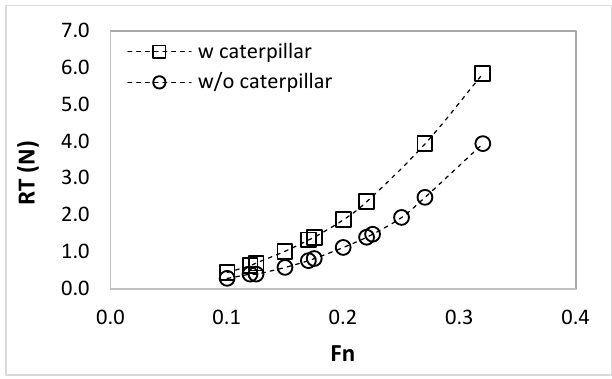
Figure 4. Numerical simulation results of vessels w/and w/o caterpillars.